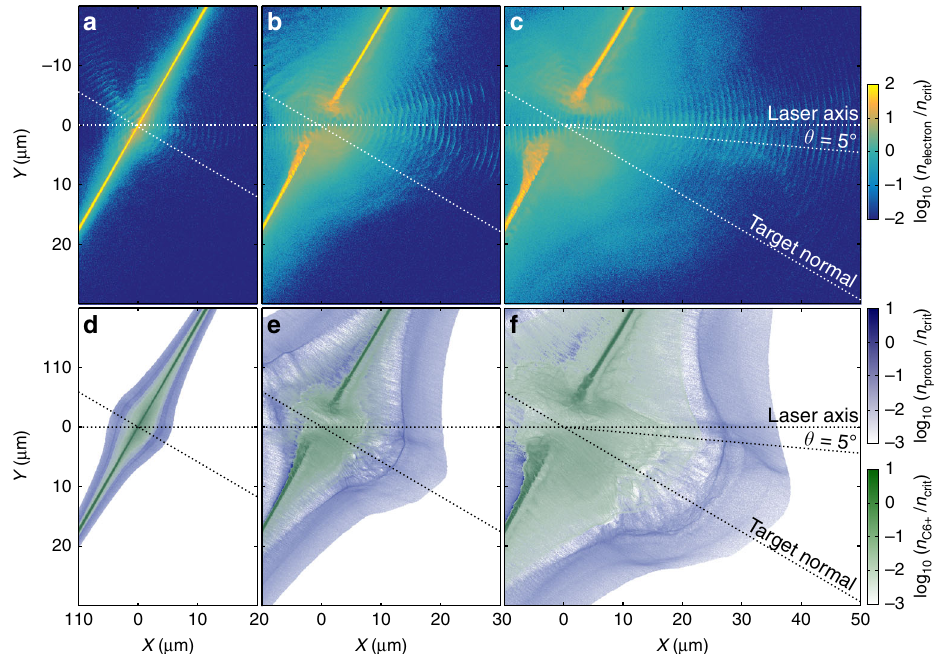
Fig. 5 Simulation results displaying the electron and ion density spatial pro fi les. a – c Electron density pro fi le at a t = − 0.2 ps, b t = 0.1 ps and c t = 0.3 ps (where time t = 0 corresponds to the peak of the pulse arriving at the target). d – f Corresponding plots showing the proton (blue) and C 6 + (green)